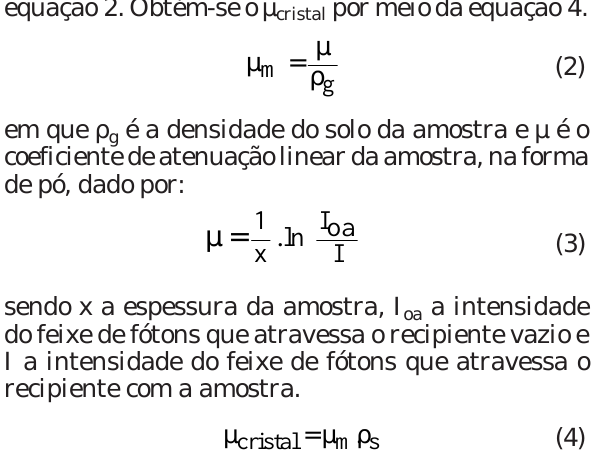
Figura 2. Diagrama mostrando as posições em que foram feitas as medidas para o cálculo dos coeficientes de atenuação linear, para calibração das tomografias em densidade das